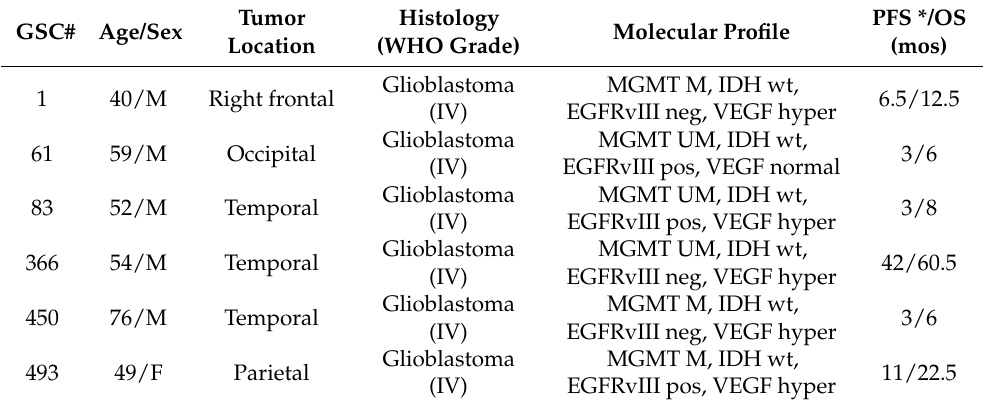
Table 2. Clinical features of GBM patients originating GSC lines.